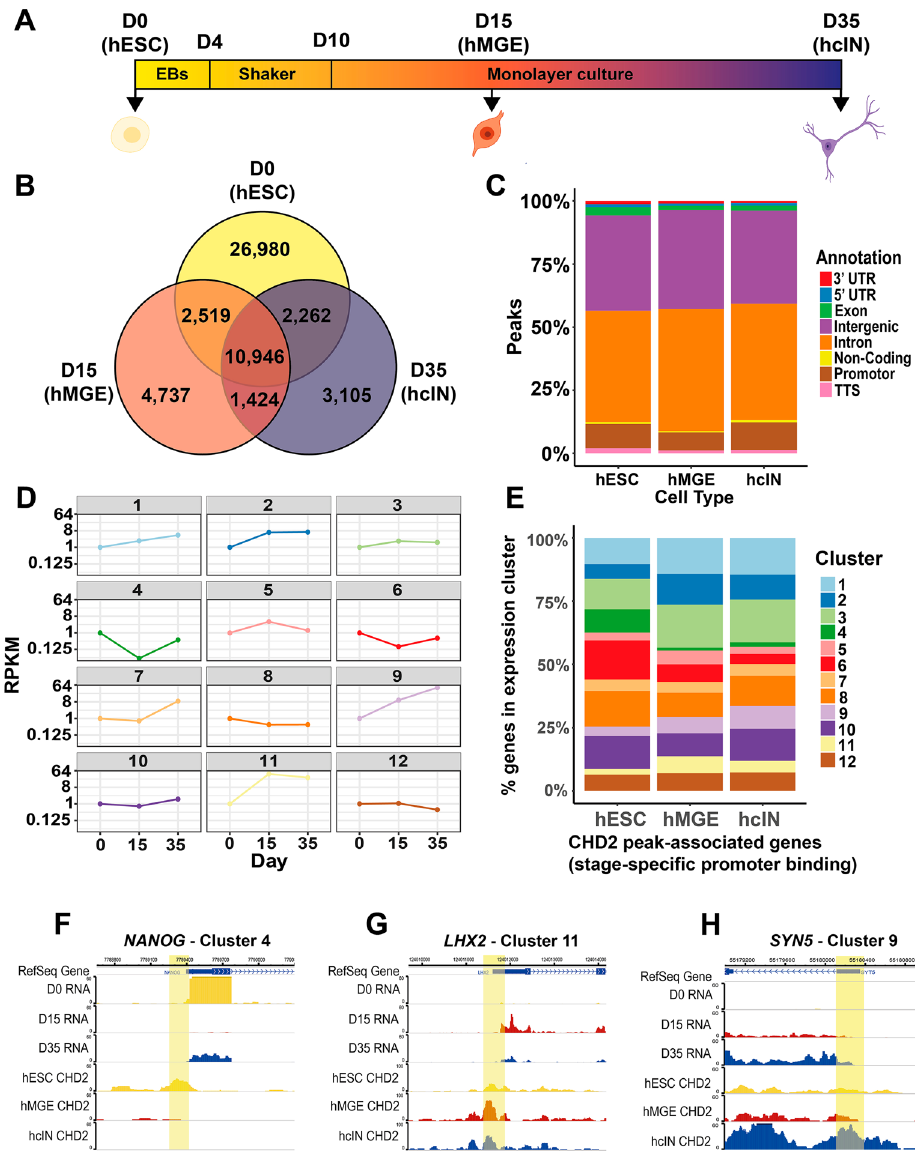
Figure 1. Genome-wide interrogation of CHD2 binding during hcIN differentiation from hESCs. ( A ) Differentiation scheme used to produce human cortical interneurons (hcINs) from human embryonic stem cells (hESCs) in vitro. Samples were collected and analyzed at day 0 (D0, hESCs), day 15 (D15; medial ganglionic eminence-like progenitors, hMGEs), and day 35 (D35, hcINs). ( B ) Number of peaks bound by CHD2 at each time point assayed, including stage-specific ’unique’ peaks (D0, D15, and D35) and peaks present at multiple time points. ( C ) Genomic annotation of CHD2 bound peaks identified in hESCs, hMGEs, and hcINs, for all peaks present at each cell stage. ( D ) Examples of gene expression during differentiation of wild type (WT) hESCs into hcINs. 12 gene expression profile clusters were generated, with all genes in each cluster having similar expression trends; each example expression profile represented here corresponds to the cluster centroid values, assuming a D0 RPKM value of 1. ( E ) Distribution of genes with stage-specific, ‘unique’ CHD2 binding at the promotor region across the 12 WT gene expression clusters. ( F – H ) Epigenome Browser views for example genes in cluster 4 ( F , NANOG ), 11 ( G , LHX2 ) and 9 ( H , SYN5 ), showing RNA expression and CHD2 binding from hESC (D0) to hcIN (D35). Promoter proximal CHD2 peaks are indicated as yellow